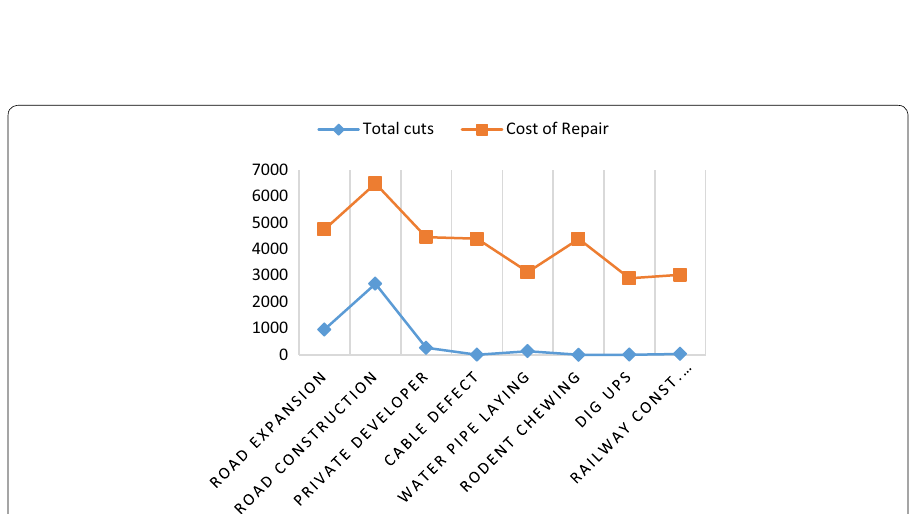
Fig. 3 Cost of repair against the cause of